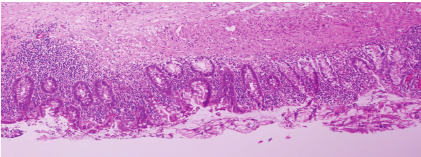
Figure 3: Biopsy from the areas of the nontumoral neobladder: small intestinal mucosa showing villous atrophy and inflammation in the lamina propria (H&E ×